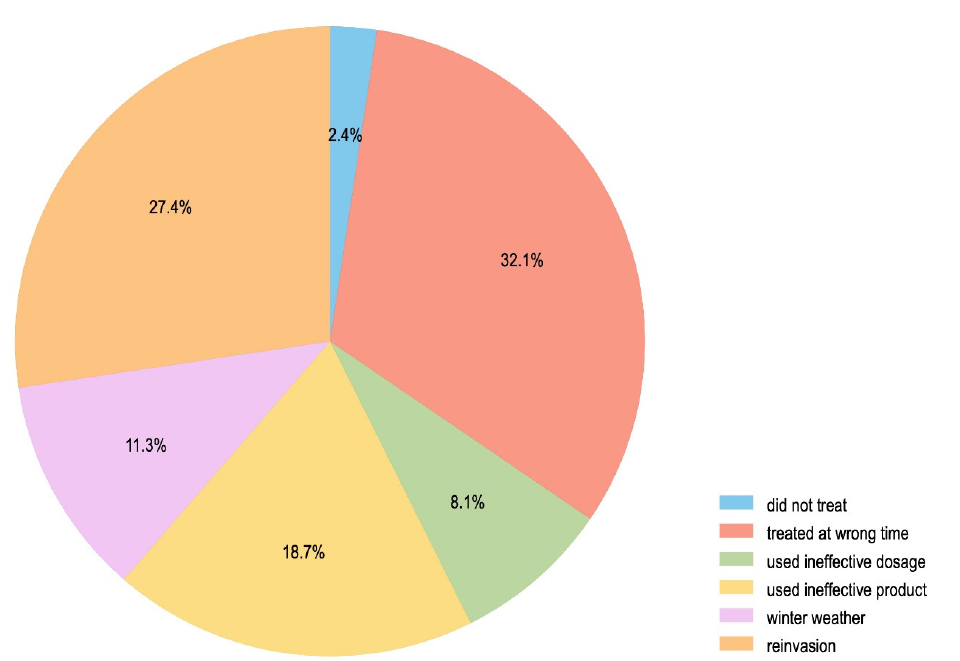
Figure 6. Reasons given for colony losses attributed to varroa during winter 2021.